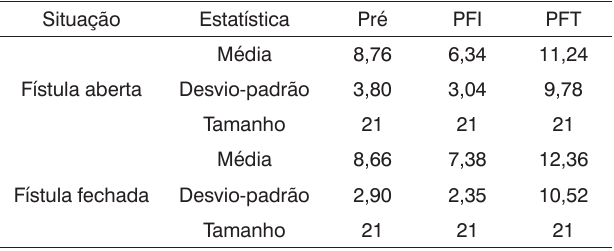
Tabela 8. Resultados do Teste de Análise de Variância (ANOVA) para a latência de PS